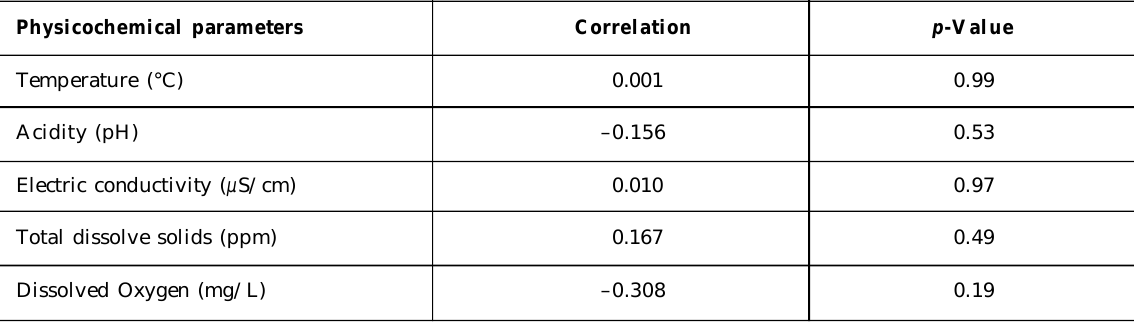
Table 4: Pearson correlation showing the association between the physicochemical parameters of breeding water and larvae abundance Physicochemical